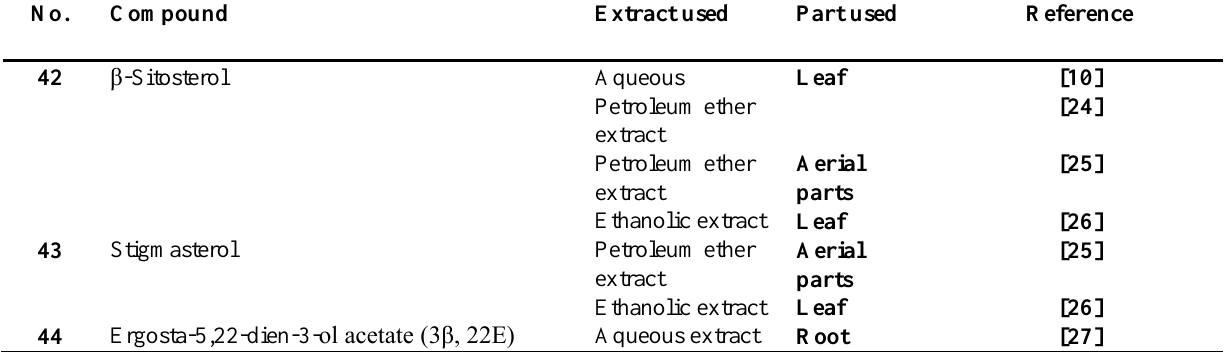
Table 5. Sterols reported in C. papaya No.